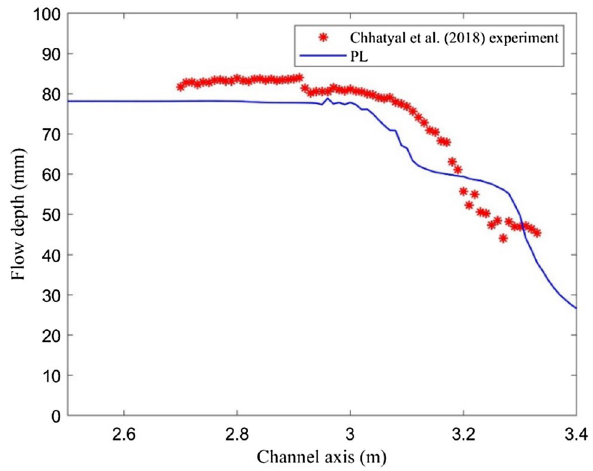
Fig. 6 A flow depth comparison with Chhantyal’s (2018) experi- mental result at a steady state with PL model results. The flow rate is 350 kg/min and the channel angle is horizontal. The power law rheo- k = n = logical parameters are 0.05 Pa s n and